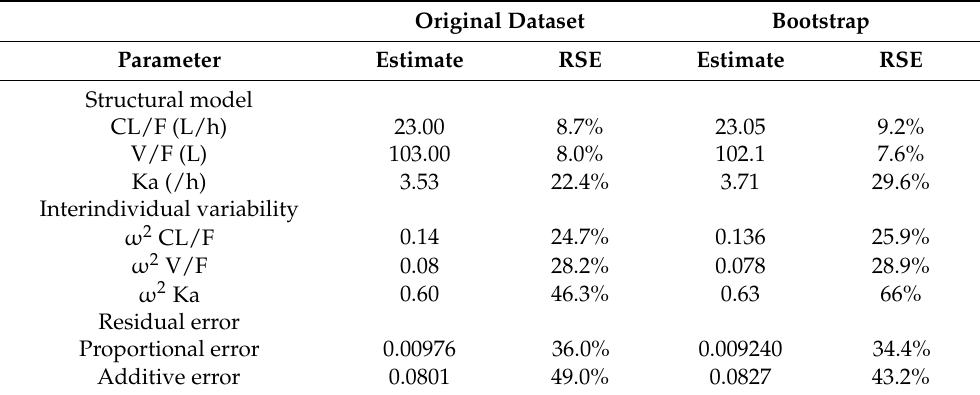
Table 2. Estimated mean population pharmacokinetic parameters and relative standard errors obtained with the original dataset and their corresponding bootstrap values.